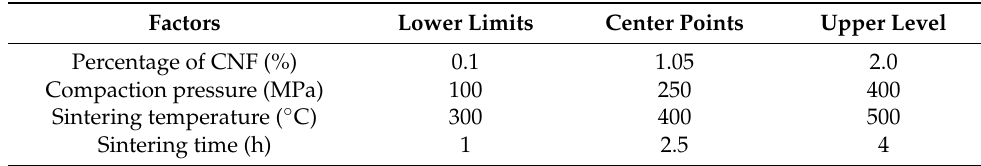
Table 1. The level of factors for two-level factorial design.